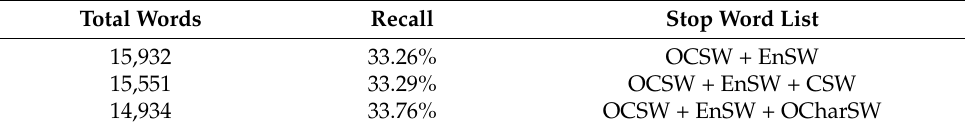
Table 11. The performance of stop